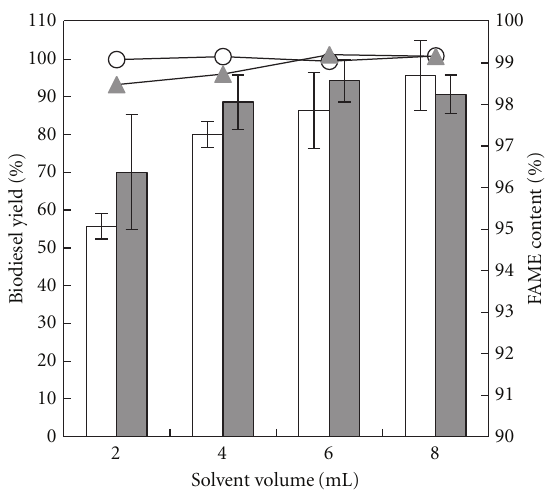
Figure 3: E ff ects of chloroform and n -hexane volume on the biodiesel yield and FAME content by in situ transesterification of C. pyrenoidosa . Reaction condition: 1 g algal powder with 4 mL methanol and 0.5 M sulfuric acid at 90 ◦ C. Solvent volume: 2, 4, 6, and 8 mL. Biodiesel yield ( (cid:3) ) and FAME content ( (cid:3) ) in the chloroform group, biodiesel yield ( (cid:4) ) and FAME content ( (cid:2) ) in the n -hexane group. Error bars = mean ± standard deviation.